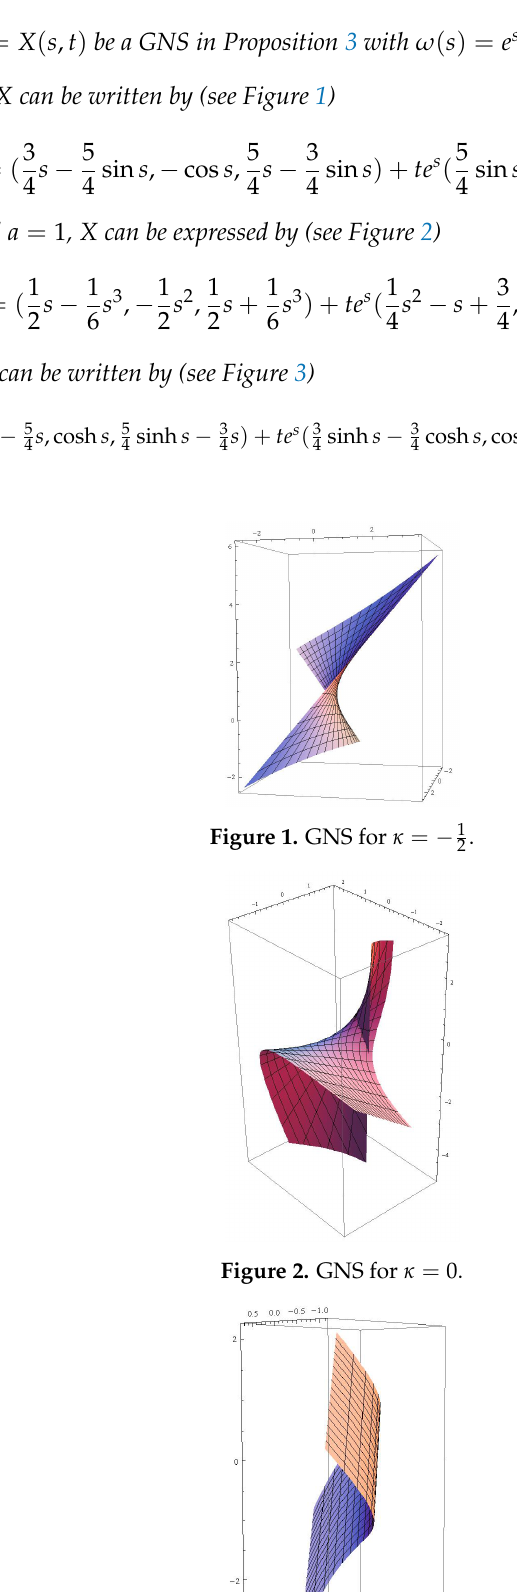
Figure 3. GNS for κ = 1